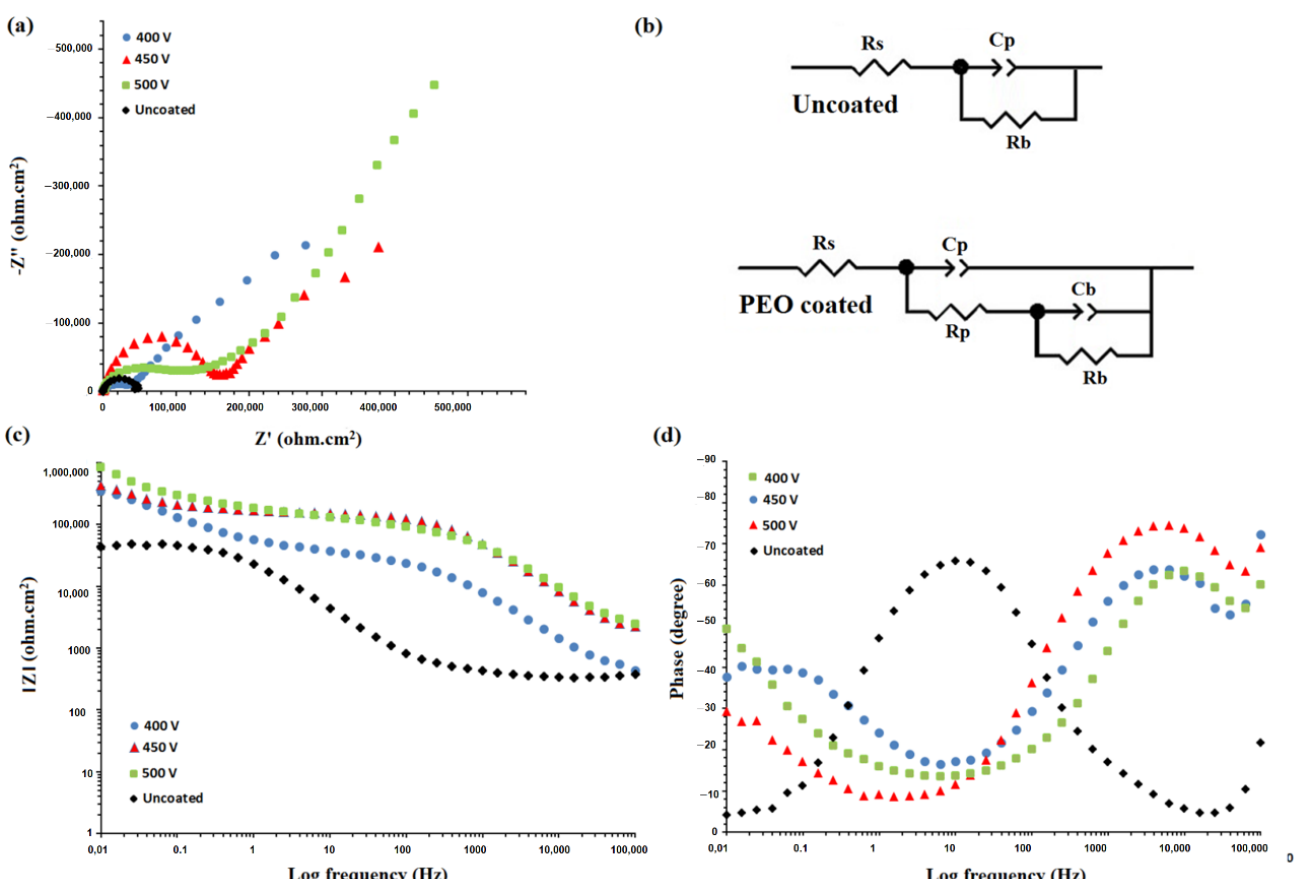
Figure 10. ( a ) Electrochemical impedance spectroscopy measurements and ( b ) Equivalent electrical circuit for bare γ -TiAl alloy (uncoated) and PEO-coated specimens and ( c ) Bode magnitude plot and ( d ) Bode phase plot of the bare and PEO-coated γ -TiAl alloy samples under different applied voltages of 400 V, 450 V, and 500 V.